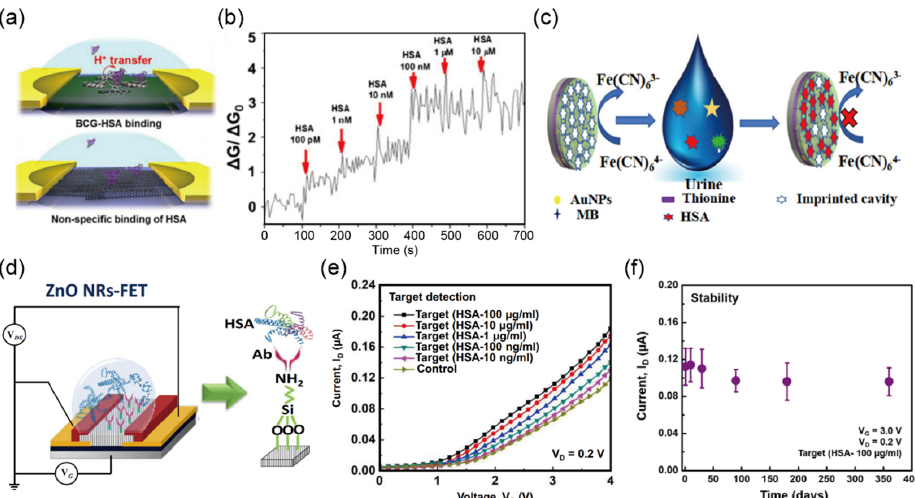
Figure 4. Selective detection of human serum albumin (HSA) in biological samples ( a ) Schematic illustration representing the operational mechanism for bromocresol green (BCG)–HSA binding. ( b ) Measurement of the conductance of the single-walled carbon nanotube (SWCNT)-field emission transistor (FET) in healthy human urine samples (reprinted with permission from Ref. [35]; copy ‐ right 2016 Springer). ( c ) Schematic illustration representing the protocol of the molecularly im ‐ printed sensor. (Reprinted with permission from Ref. [36]; copyright 2019 Elsevier.) ( d ) Schematic